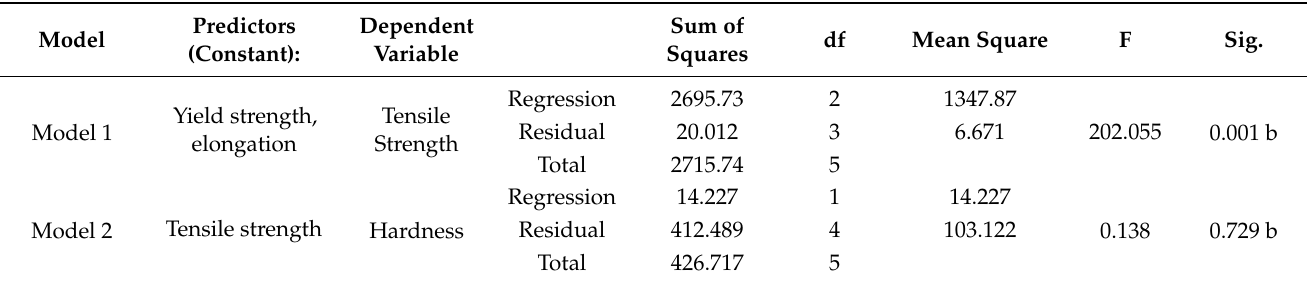
Table A3. ANOVA of statistical differences among variables.